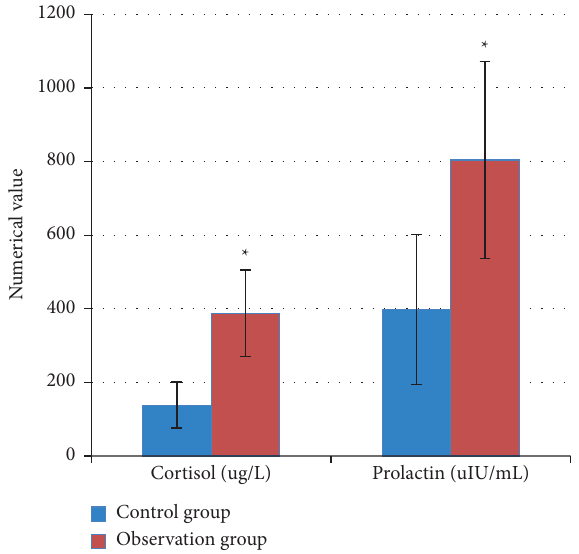
Figure 3: Comparison of cortisol and prolactin levels. ∗ Com- pared with control group, P < 0 . 05. Table 4: Cortisol analysis of cortisol and prolactin levels and PANSS total